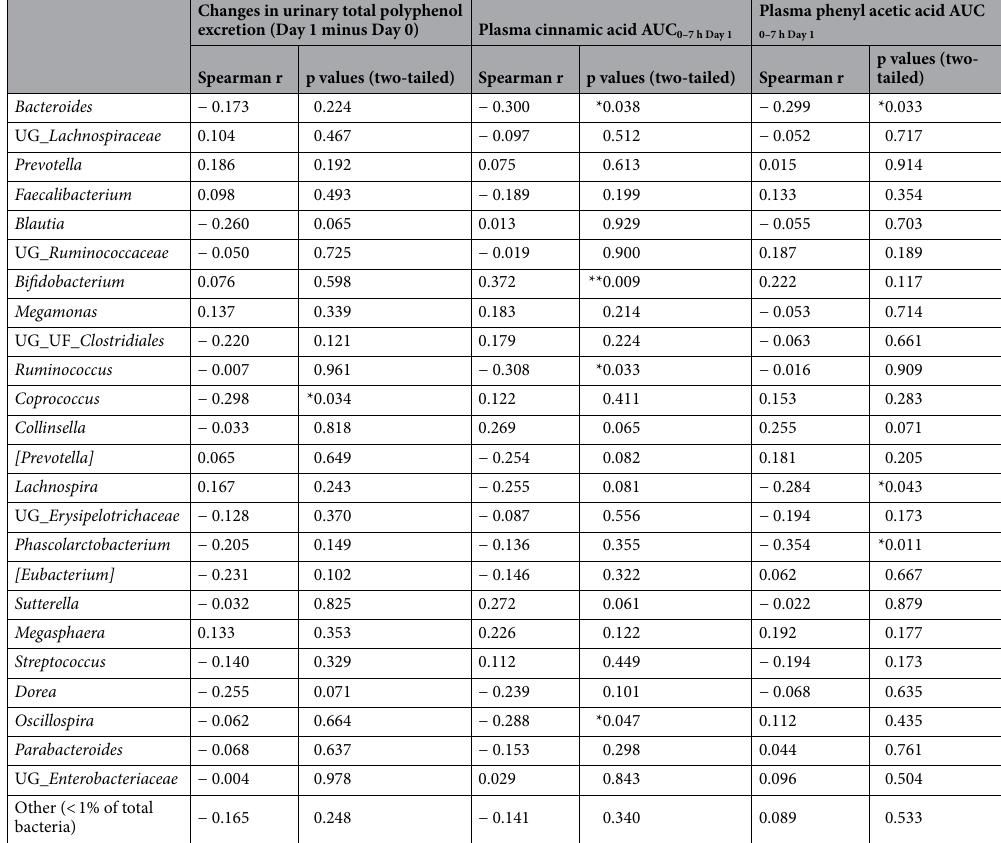
Table 2. The correlation between changes in 24 h urinary total polyphenol excretion, plasma cinnamic acid AUC correlation coefficient (r) and two-tailed p values were shown. AUC area under curve, UG unknown genus, UF unknown family. n = 15 each intervention. **p ≥ 0.001– < 0.01, *p <